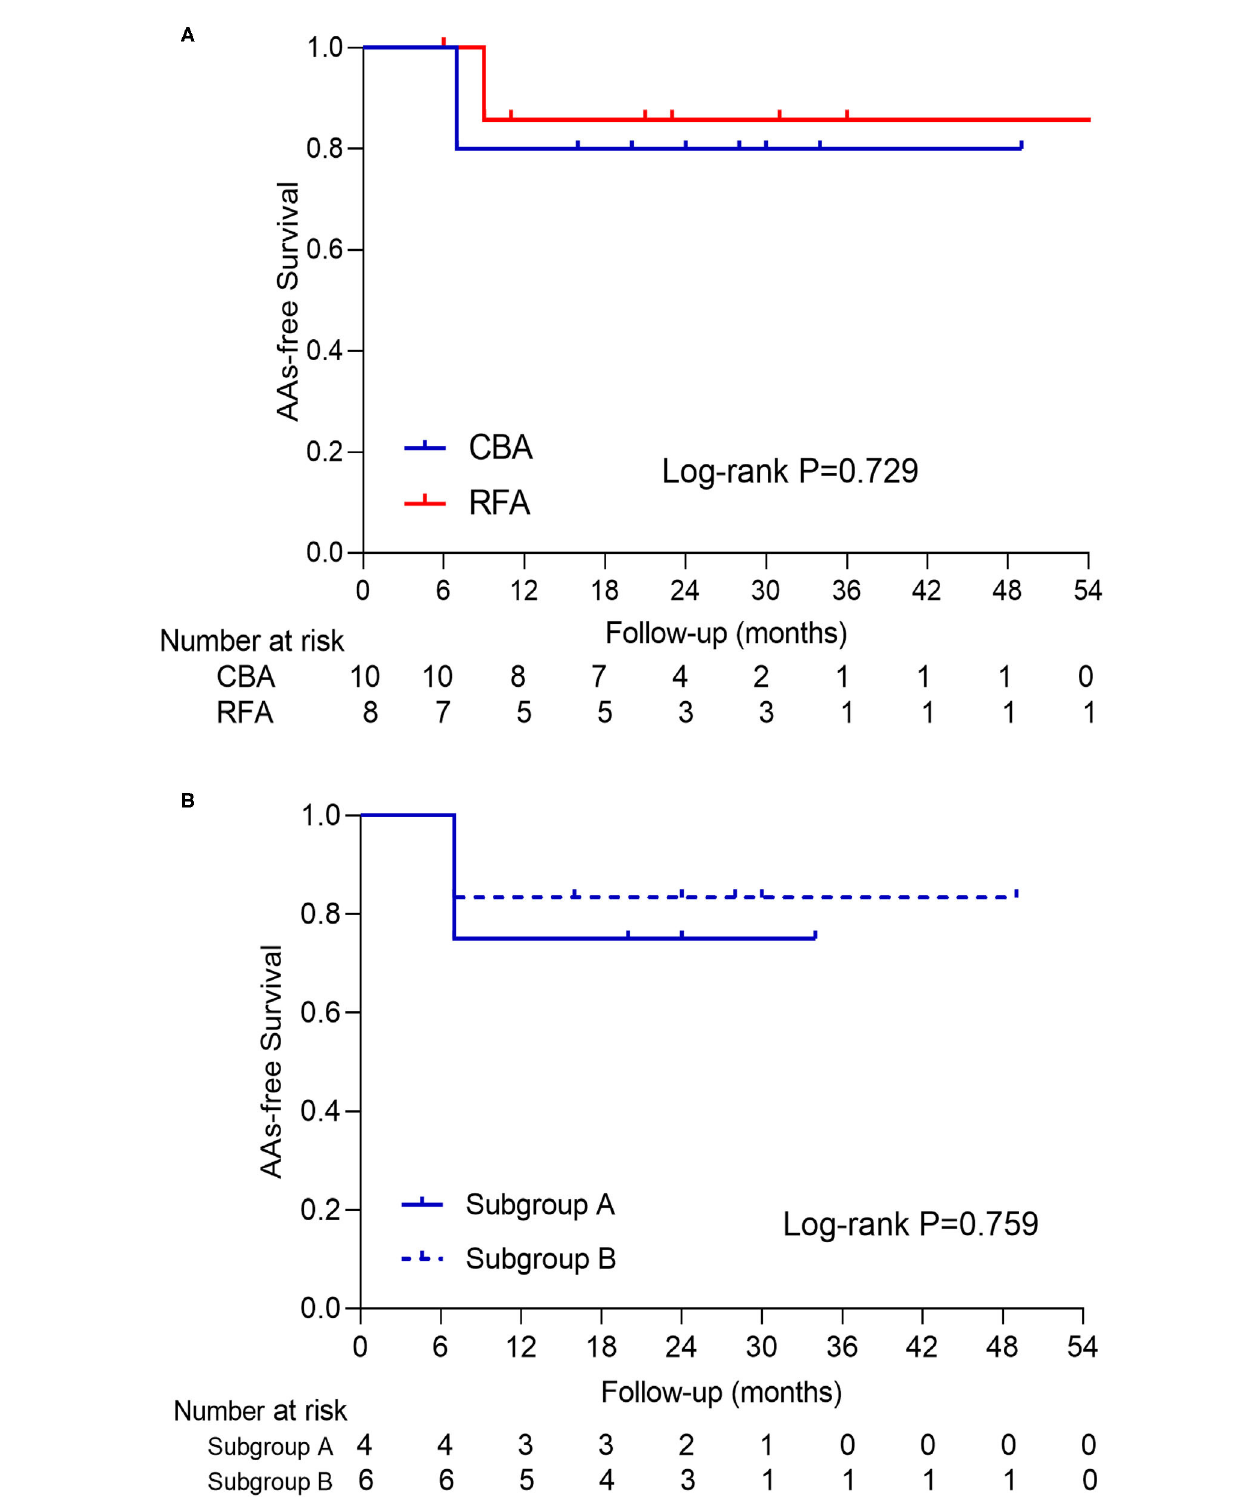
FIGURE 4 | The presentation of AAs-free survival curve of patients in (A) CBA and RFA and (B) subgroup A and B. No log-rank P -value with statistical significance was seen in either curve. AAs, atrial arrhythmias; CBA, cryoballoon ablation; RFA, radiofrequency ablation.